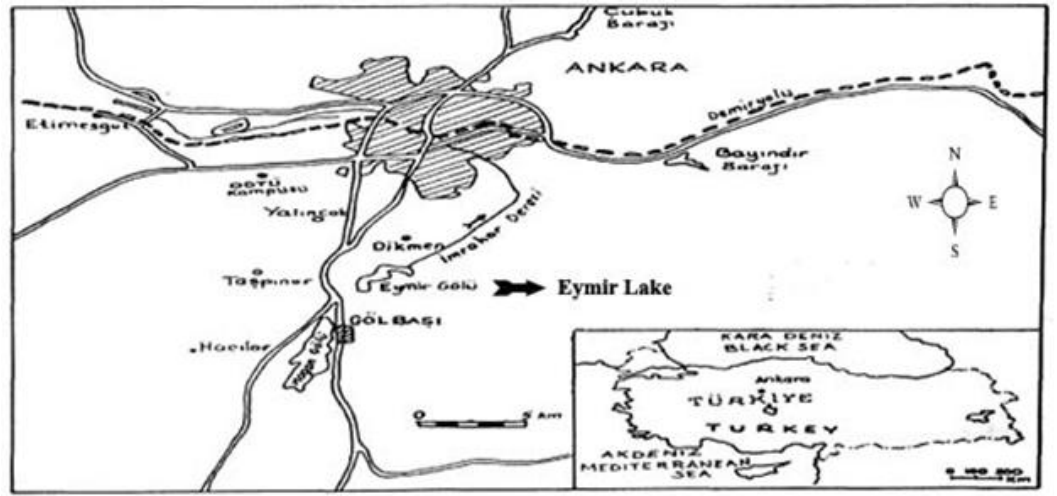
Fig. 1: Lake Eymir position in Turkey